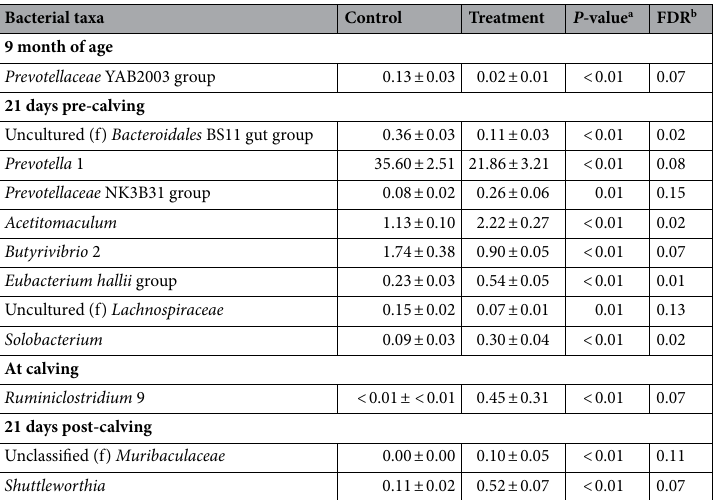
Table 1. Bacterial taxa showing significant differences between the control and treatment groups at 9 months of age and around calving. Values are presented as the mean ± standard error of relative abundance (percentage of total reads). a P -values were calculated using the negative binomial model implemented as a Wald test in the DESeq2 package in R. b False-discovery rate; statistical significance was determined using an FDR threshold of <